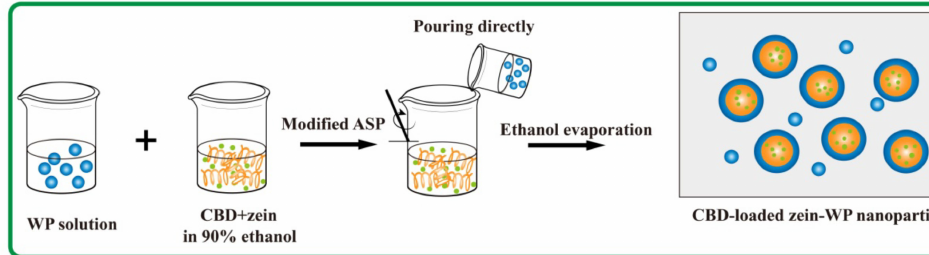
Figure 1. Synthesis of CBD-loaded zein–WP